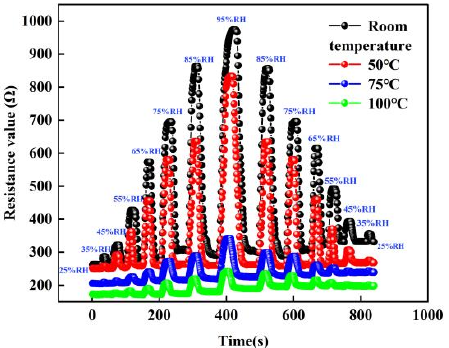
Figure 11. The resistance change curve of sensor at different temperature and humidity environments.